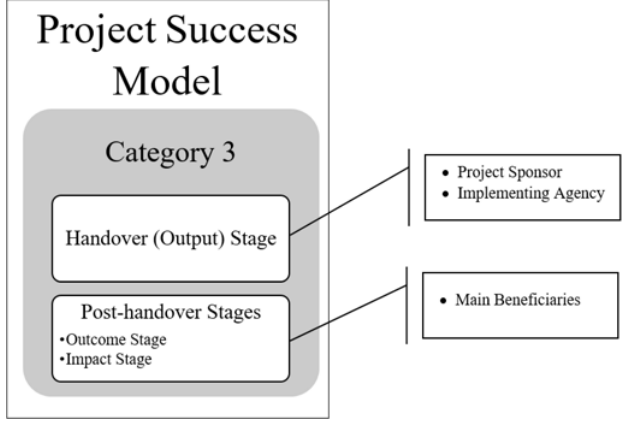
Figure 2 Success Model at Different Stages by Different Stakeholders for ID